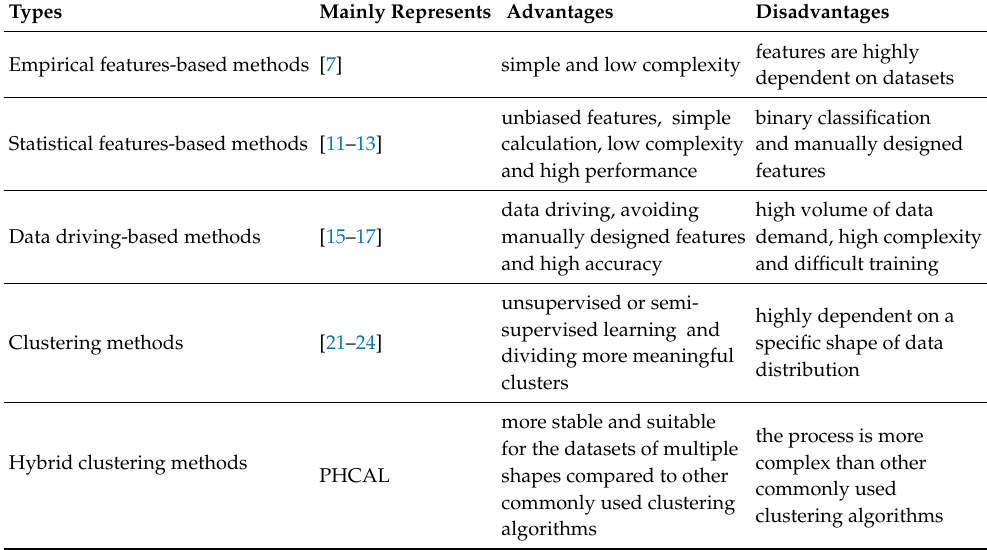
Table 1. The advantages and disadvantages of several kinds of artificial intelligence methods.